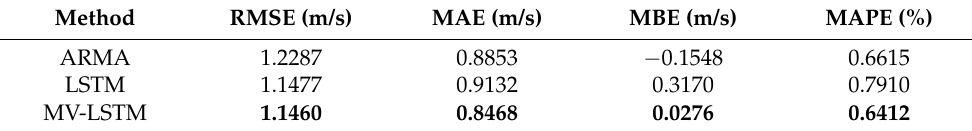
Table 5. The evaluation metric values for three models on the test set of Yanqing Station.